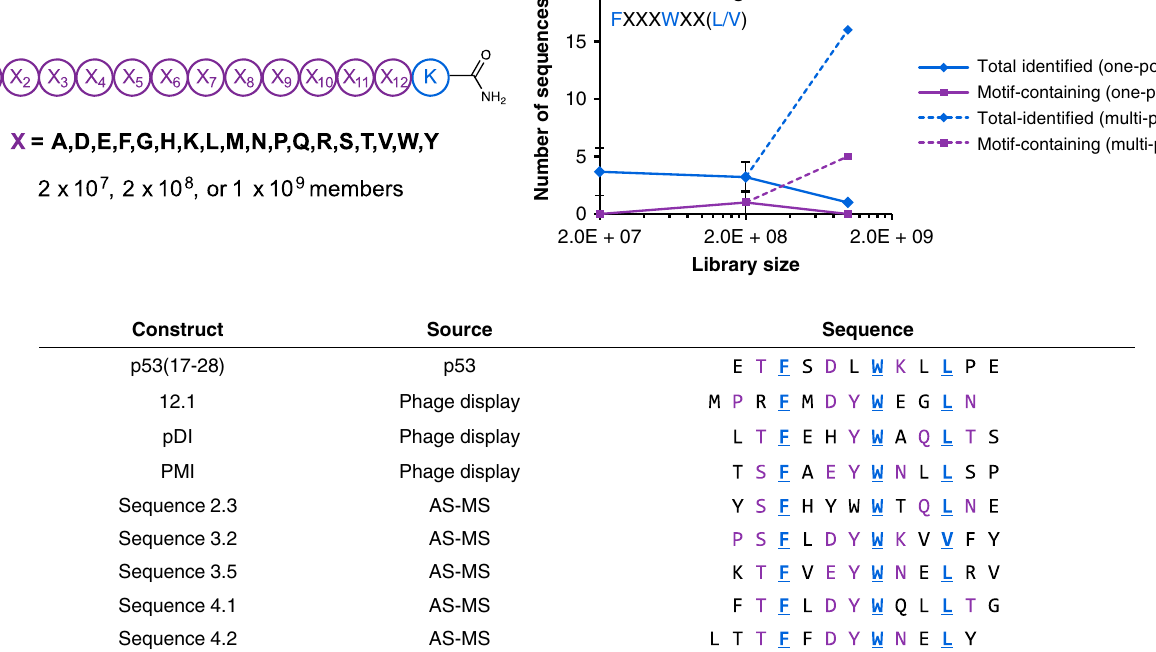
Fig. 4 High-diversity libraries facilitate discovery of p53-like peptides. a Design of libraries used in selections against MDM2. Each library was derived from the same batch of split-and-pool SPPS. The readout for selections was the number of sequences bearing the MDM2-binding motif, FXXXWXX(L/V). b Motif-containing sequences could be identi fi ed by selection from individual 2 × 10 8 -member libraries (one-pot), but not from 2 × 10 7 -member or 1 × 10 9 - member libraries (obtained by pooling the fi ve individual 2 × 10 8 -member libraries; one-pot). Selections from the fi ve individual 2 × 10 8 -member libraries (multi-pot; 1 × 10 9 members total) identi fi ed fi ve motif-containing sequences, suggesting that library size was enabling for identi fi cation of p53-like peptides as long as the mixture was not overly complex. Error bars correspond to one standard deviation among three technical replicates. c Sequences of known MDM2-binding peptides, including the native MDM2-binding epitope of p53 (residues 17 – 28) and three peptides identi fi ed from phage display, aligned with sequences identi fi ed from b . Known hot spot residues (F, W, L/V) are indicated in blue; aligned hot spot positions are indicated in bold and underline; and additional conserved residues are indicated in